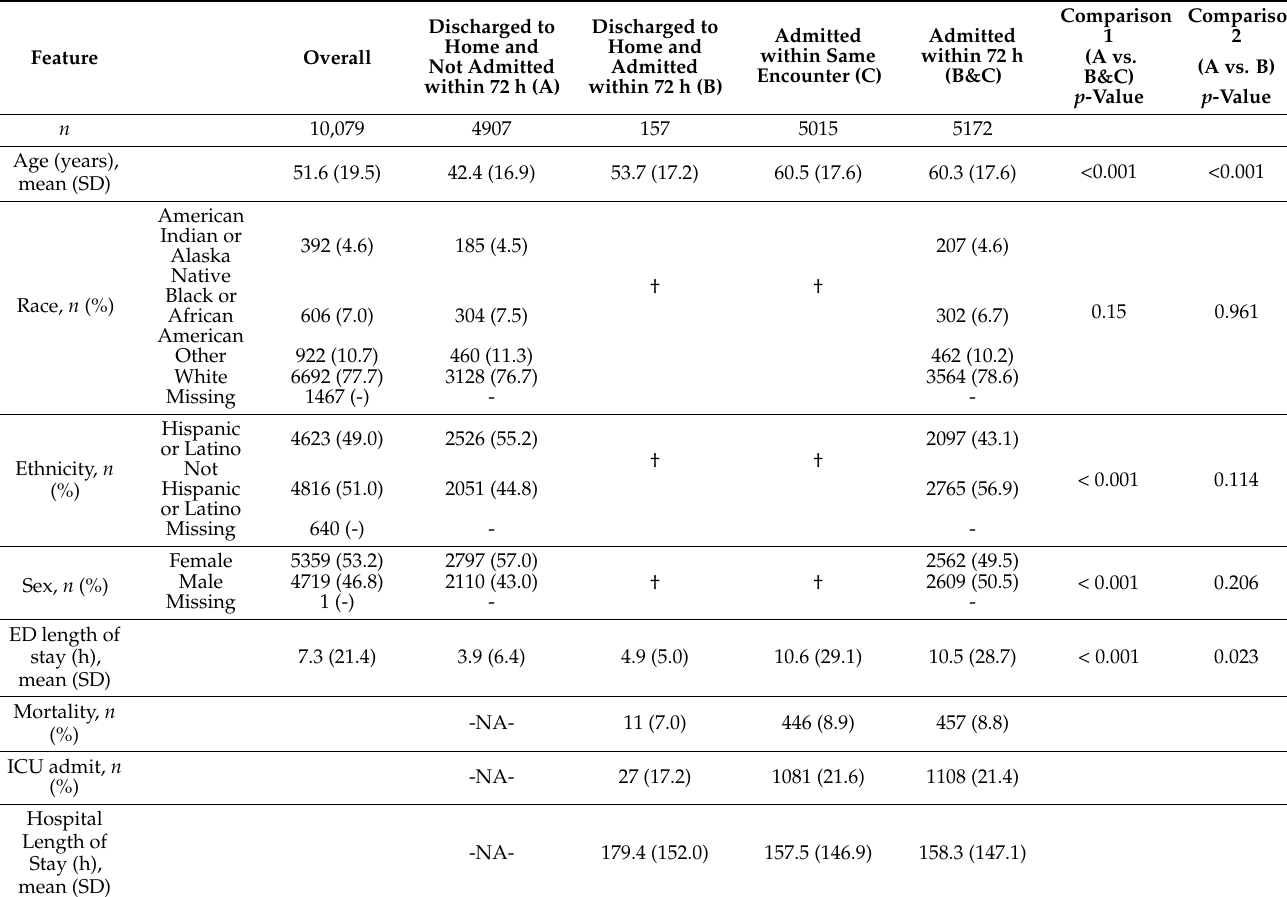
Table A1. ED patient characteristics (age, race, ethnicity, sex), ED length of stay, and outcomes. The “Missing” categories were not included in the calculation of proportions or statistical analysis.